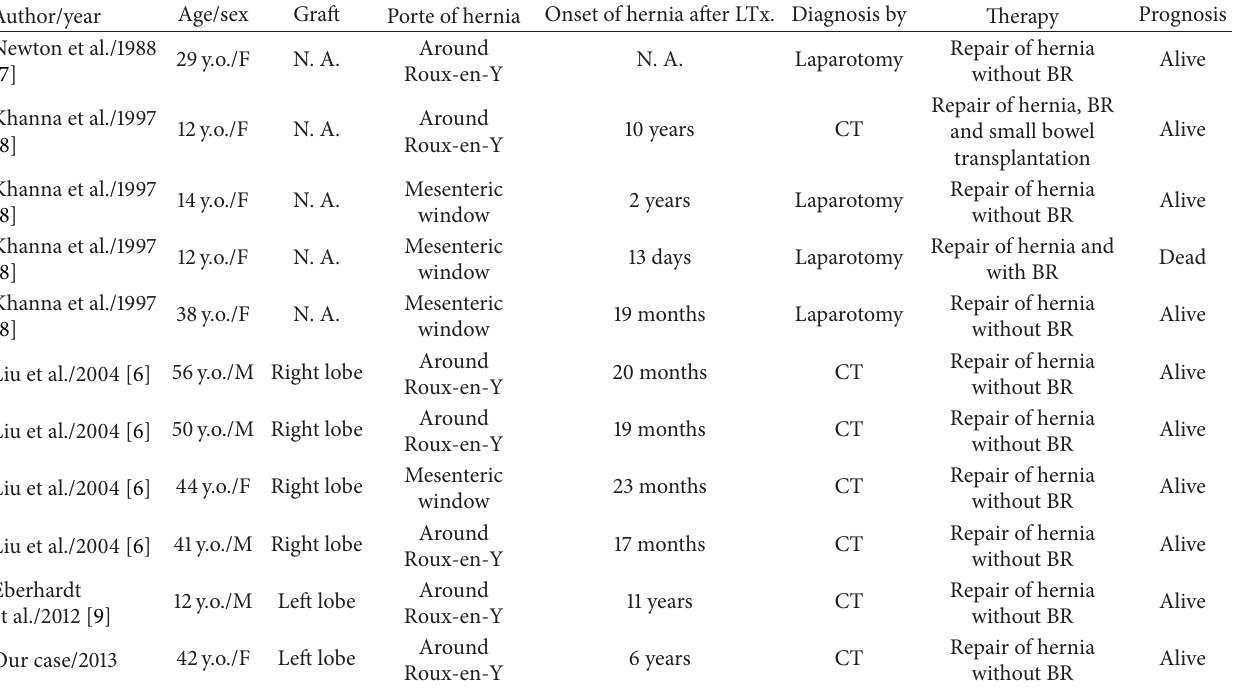
Table 1: Summary of the clinical data of all reported cases.